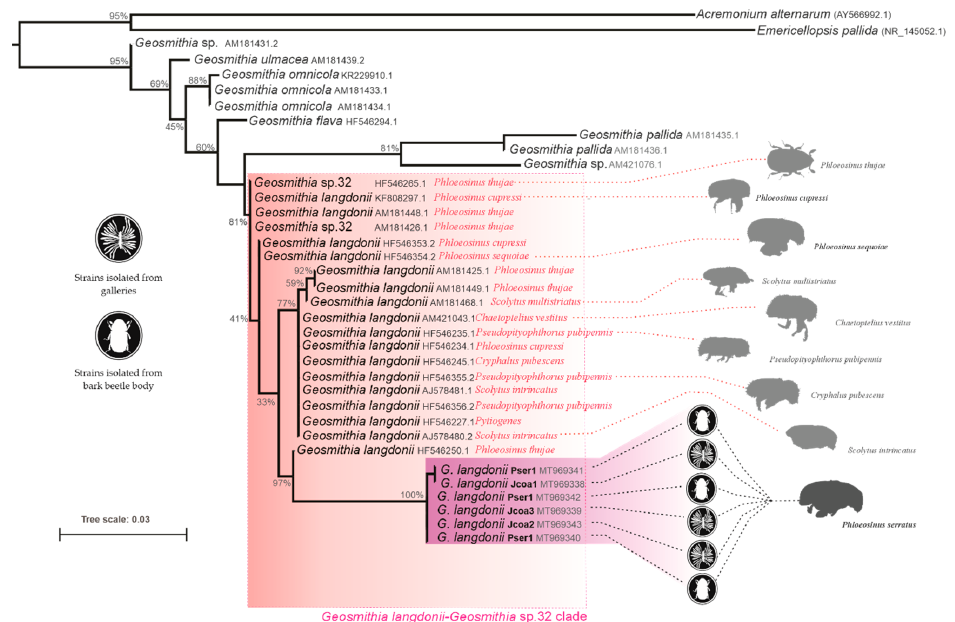
Figure 4. Phylogenetic relationships among strains from Geosmithia langdonii-Gesomithia sp.32 from Galeana, Nuevo León and its most closely related species based on the ITS sequences. The phylogenetic tree was obtained by ML analysis of 34 ITS sequences of Geosmithia langdonii and Geosmithia sp. 32. Emericellopsis pallida and Acremonium alternarum were selected as outgroups. Acronyms Pser and Jcoa correspond to strains isolated from Phloeosinus serratus and Juniperus coahuilensis , respectively.